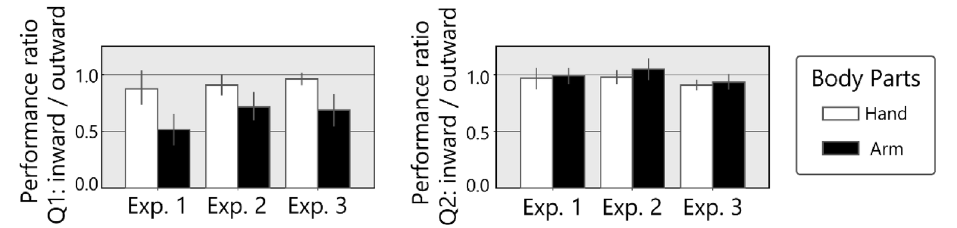
Figure 5. Comparison of performance in direction judgments for different stimulus trajectories. Performance ratio represents the task performance when the stimuli were on the inwardly inclined path (LD and RU) divided by that when the stimuli were on the outwardly inclined path (LU and RD). The left panel shows the ratios for Q1 and the right panel for